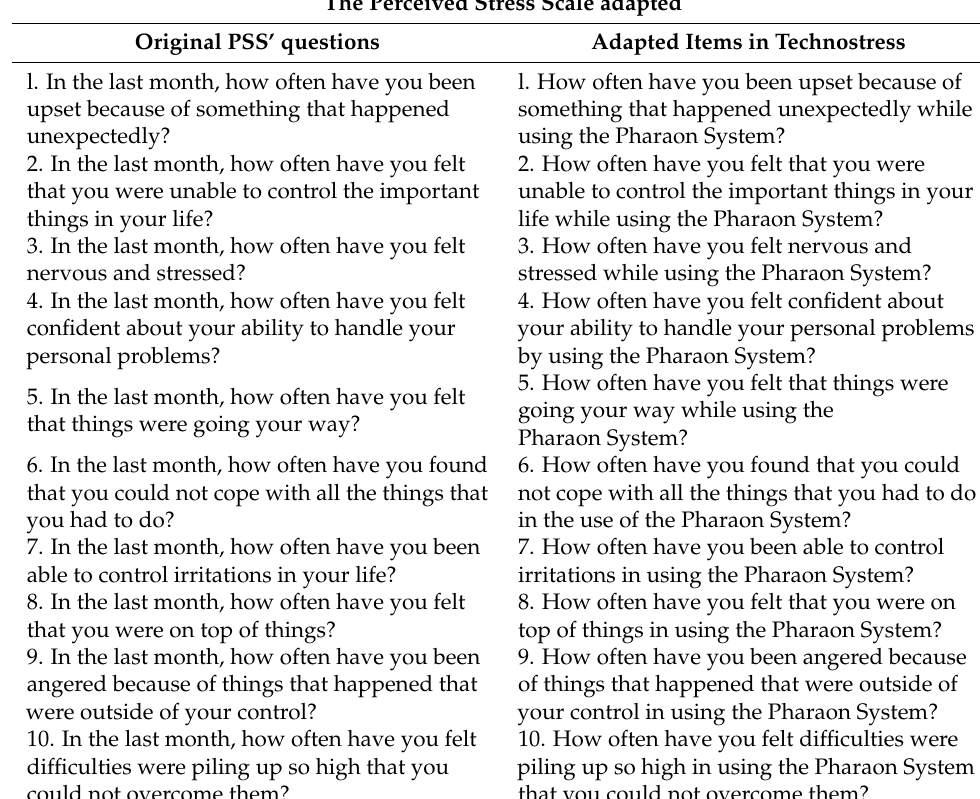
Table A2. Original PSS test questions and adapted PSS test questions.